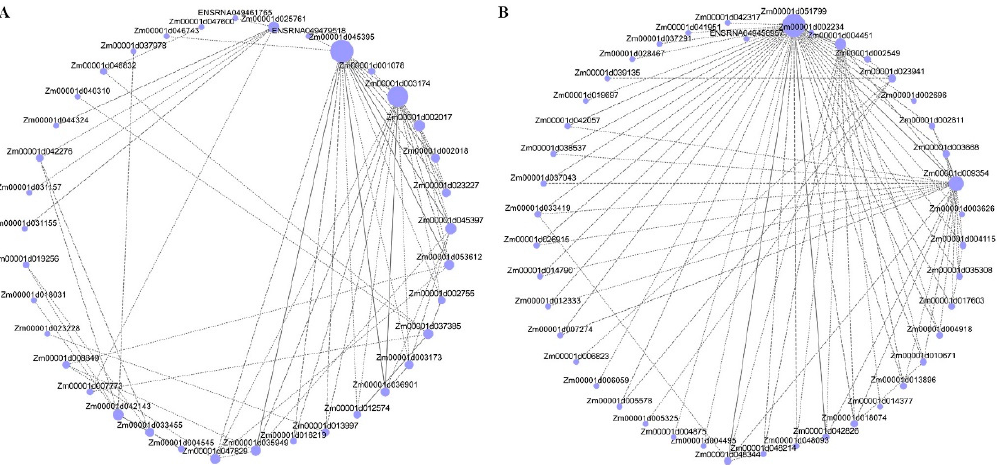
Figure 8. Analysis of hub genes network interaction in phenotypic significant enrichment module. ( A ) Network interaction analysis of hub genes in grey60 module. ( B ) Network interaction analysis of hub genes in lightgreen module. The size gradient of the points represents the level of the soft threshold of connectivity.